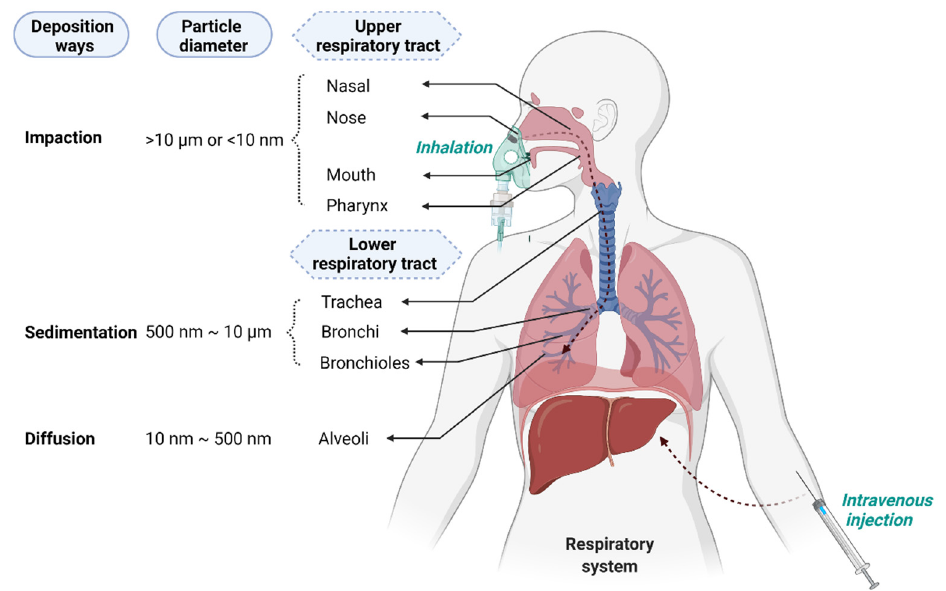
Figure 4. Intravenous delivery vs. lung delivery of NP-siRNAs. Intravenous delivery can deliver therapeutic siRNAs directly to the liver via the circulatory system. Lung delivery can deliver siRNAs into the respiratory tract through the mouth or nose, and the deposition distance depends mainly on the size and density of the particles. Aerosols with an aerodynamic diameter >10 µ m will deposit in the nasal cavity and pharynx through impact, and particles with a diameter of <10 nm with high diffusion velocity are more likely to be deposited in the upper respiratory tract [231,232]. Particles between ~1 and 10 µ m will be deposited in the bronchi and bronchioles through sedimentation; particles with diameters ranging between 10 and 500 nm will deposit in the lower bronchioles and alveoli by diffusion. Created with BioRender.com.